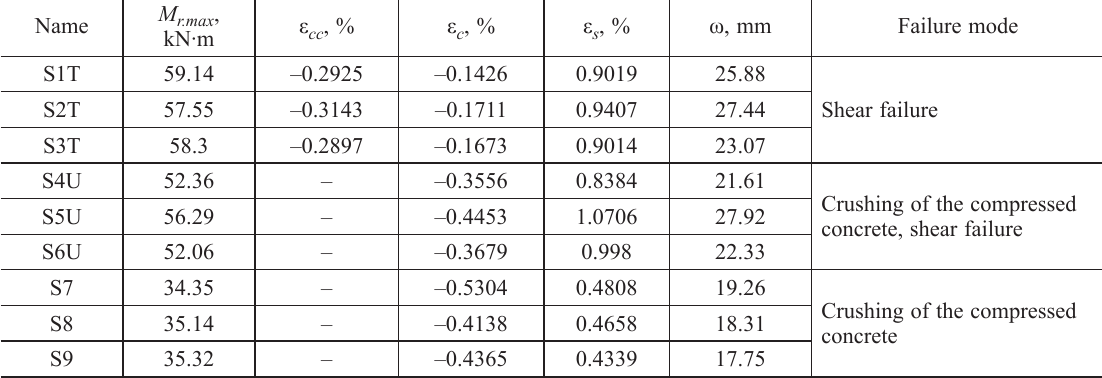
Table 9. Maximal bending moment and strains at this